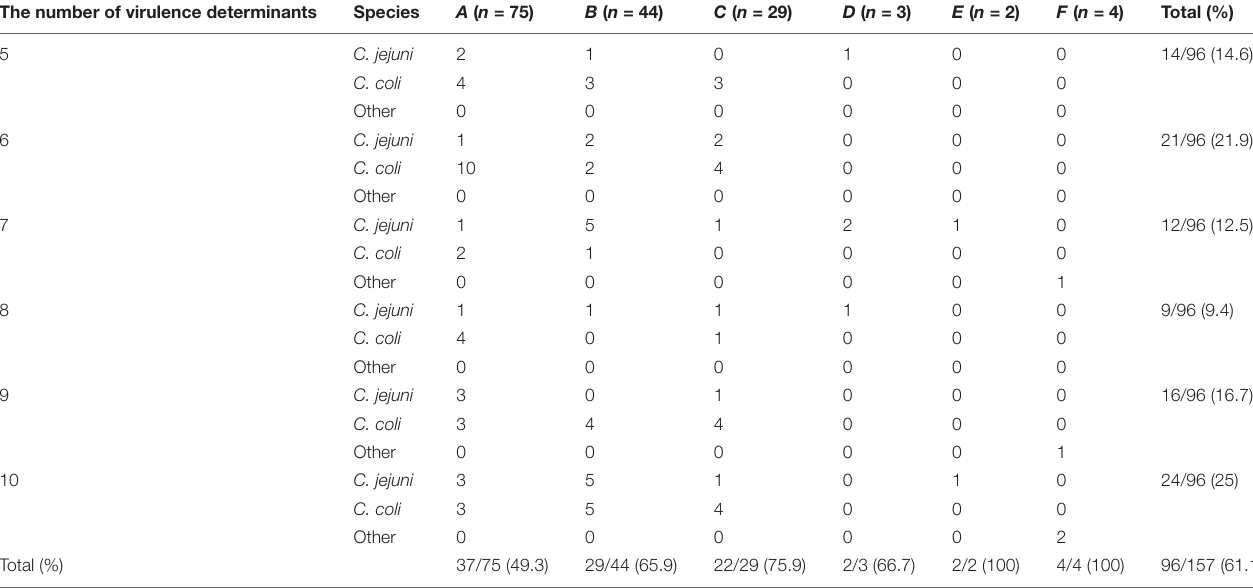
TABLE 4 | Campylobacter spp. isolates coharbored the number of virulence determinants in different sources and species. The number of virulence